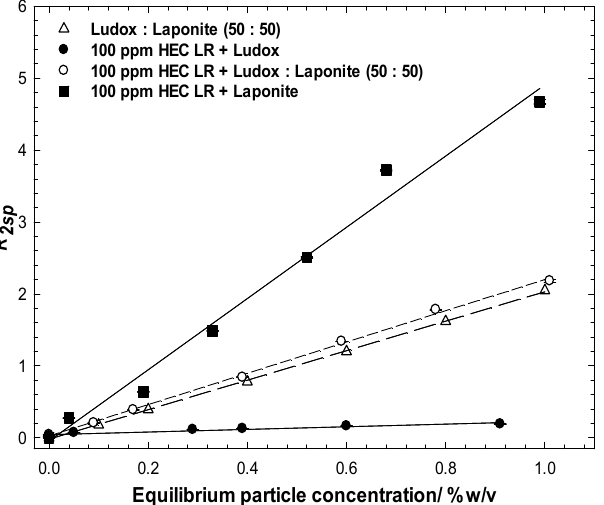
Figure 6. Comparison of the solvent-specific relaxation rates of Ludox:laponite (50:50) mixtures with their mixtures with the polymer. Mixtures of the polymer with the individual particles have been included for comparison.